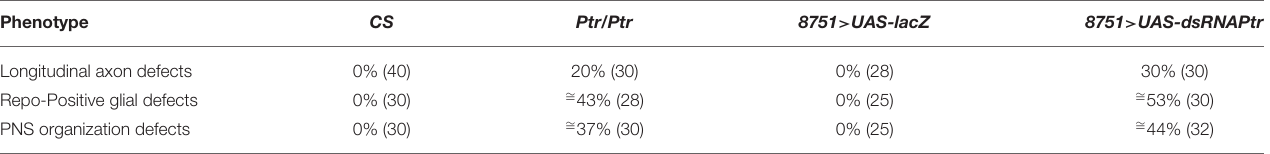
TABLE 1 | Penetrance of SN